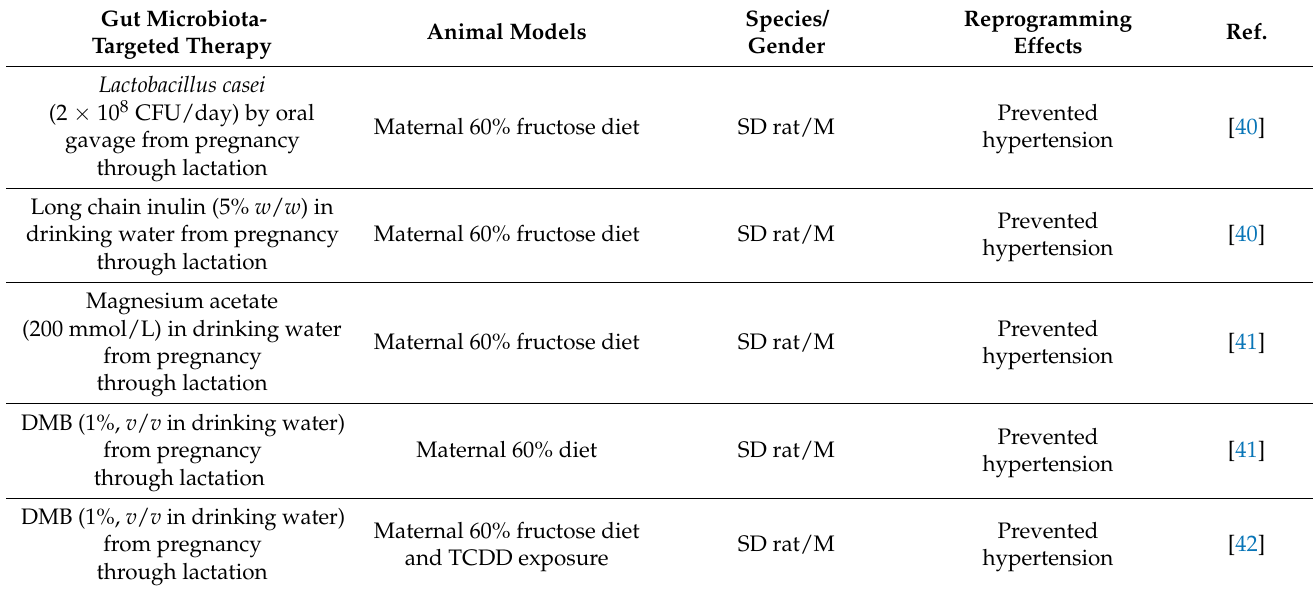
Table 2. Gut microbiota-targeted therapies used as a reprogramming strategy for maternal fructose diet-induced adult disease.